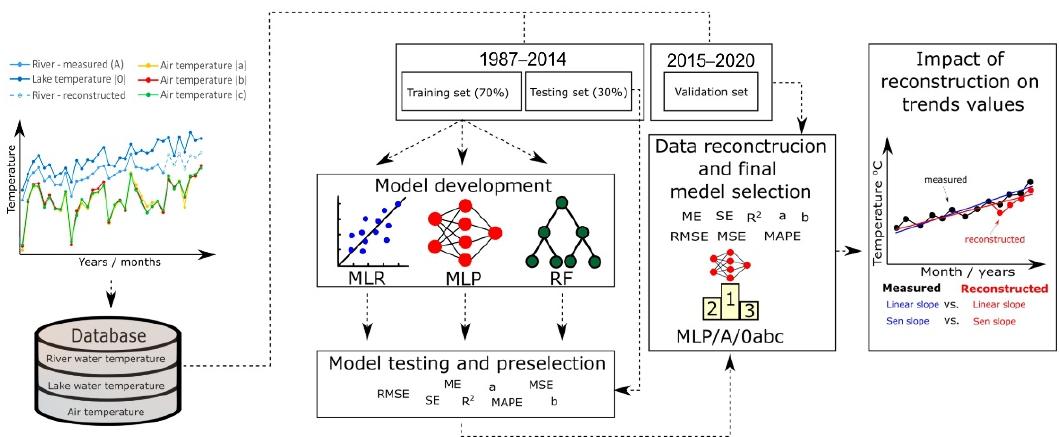
Figure 2. Diagram of data reconstruction and uncertainty of climate change estimation.